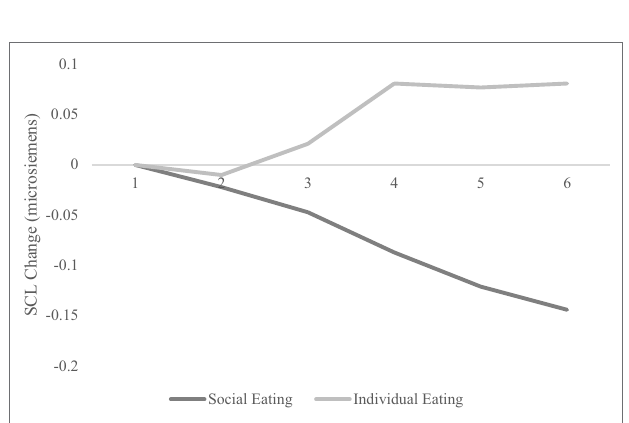
FIGURE 5 | Skin conductivity level as a function of time of exposure and type of social eating cues present in the obesity PSA